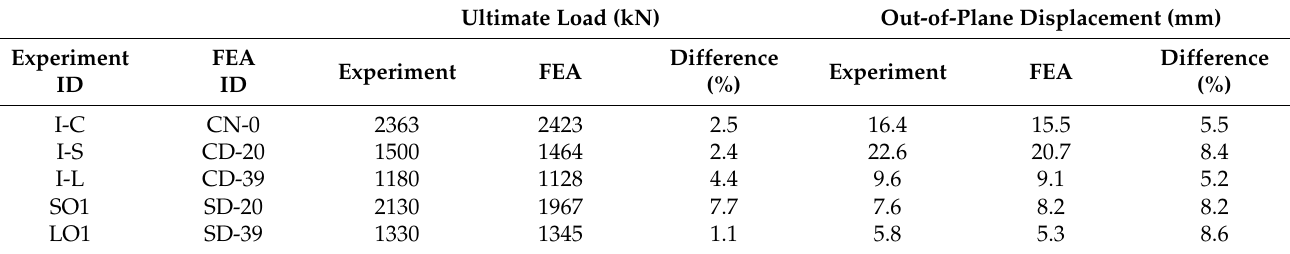
Table 2. Results of the experiment and FEA